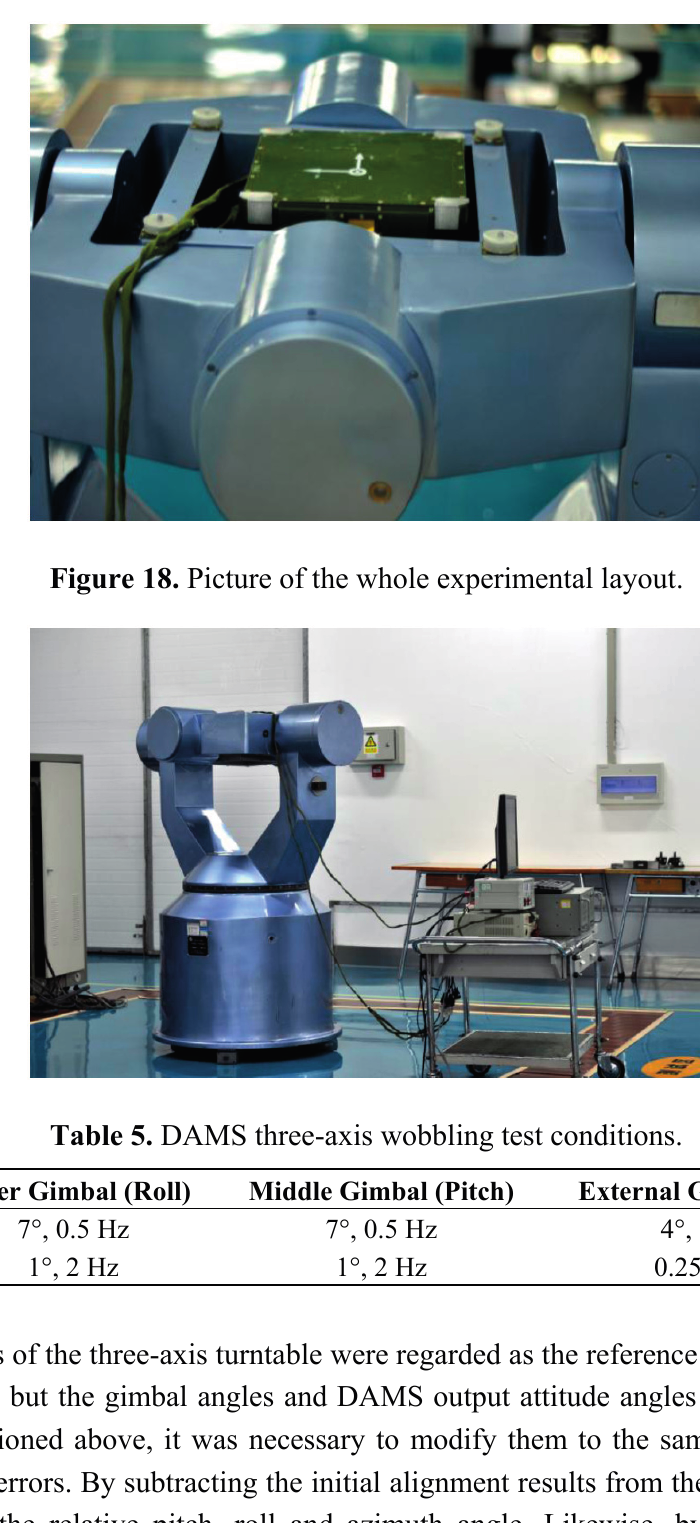
Figure 17. Picture of DAMS mounted on the three-axis turntable.